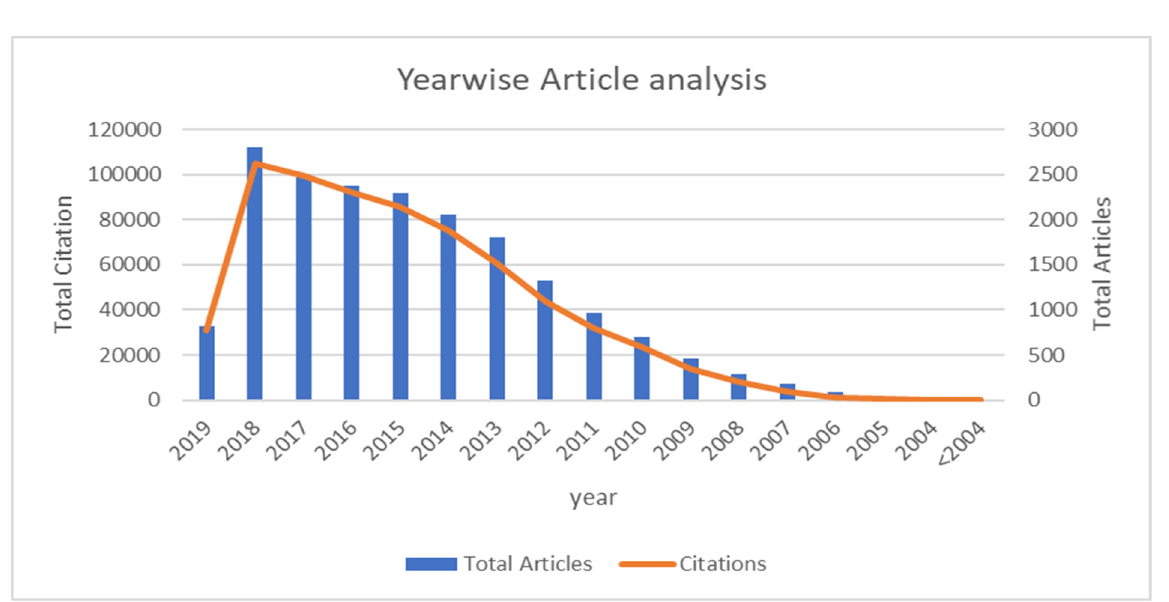
Figure 2. Year-wise article analysis.